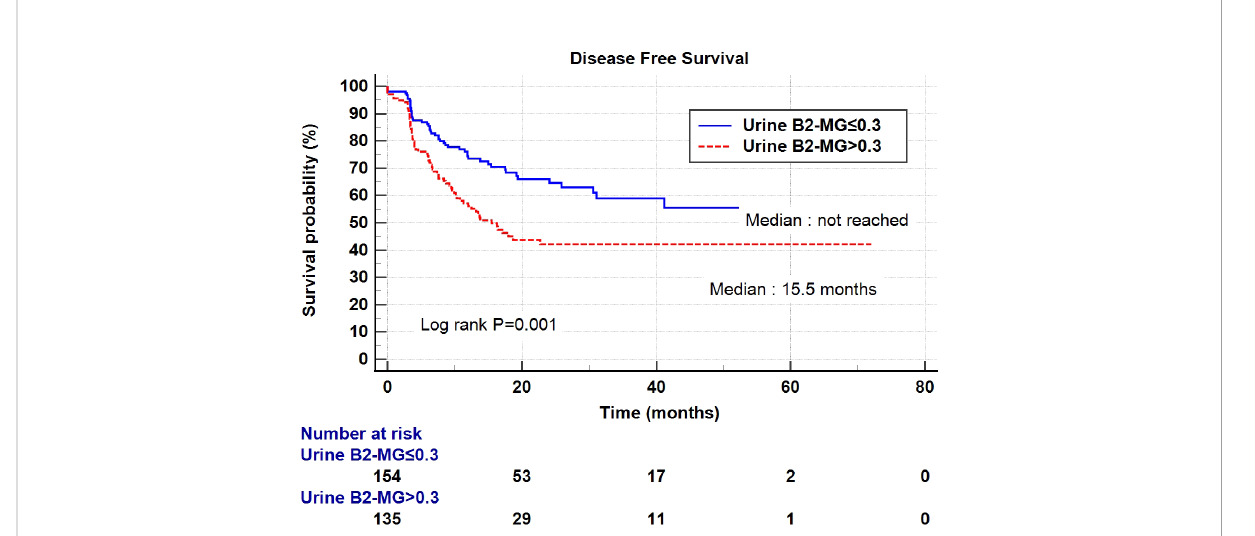
FIGURE 1 Kaplan-Meier curve of the effect of low urine B2-MG ( ≤ 0.3) (blue) and high urine B2-MG (> 0.3) (dotted red) groups on disease-free